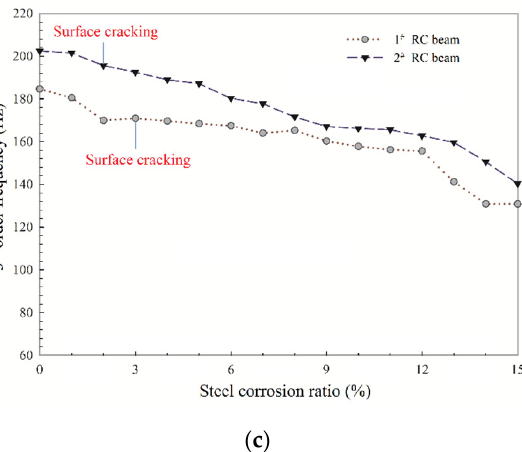
Figure 8. Effect of steel corrosion on natural frequencies of the two RC beams: ( a ) first-order frequency; ( b ) second-order frequency; ( c ) third-order frequency.